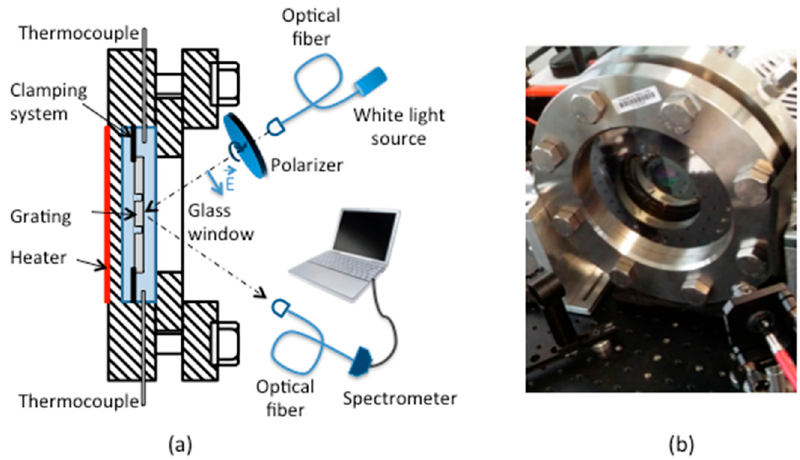
Figure 8. Sensor for surface temperature measurement via a plasmonic response. ( a ) Set-up; ( b ) photograph.